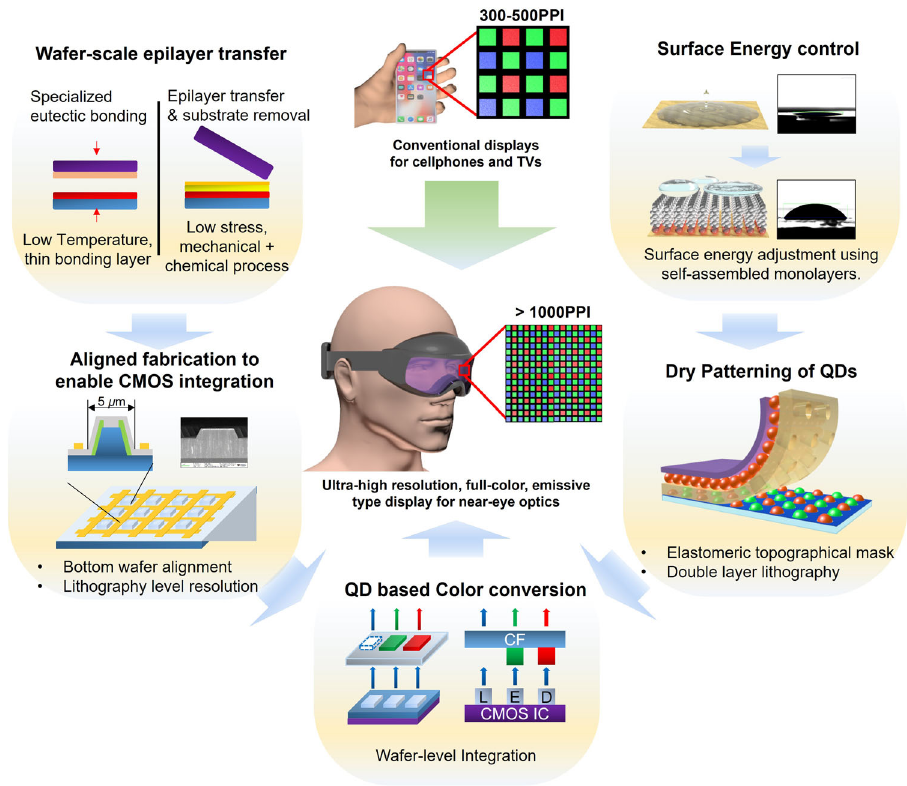
Fig. 1 An overview of the key technologies used in this study to achieve an emissive-type RGB micro-LED array with over 1000-PPI resolution. a Wafer-scale GaN epilayer was transferred using a low temperature bonding process. b The epilayer was bonded with lithographic precision in alignment for future CMOS integration. c Surface energy was modi fi ed with self-assembled monolayers for dry patterning of QDs. d A double layer elastomeric mask was used to dry pattern the QDs without using any solvent. e QDs were used for spectrally pure color